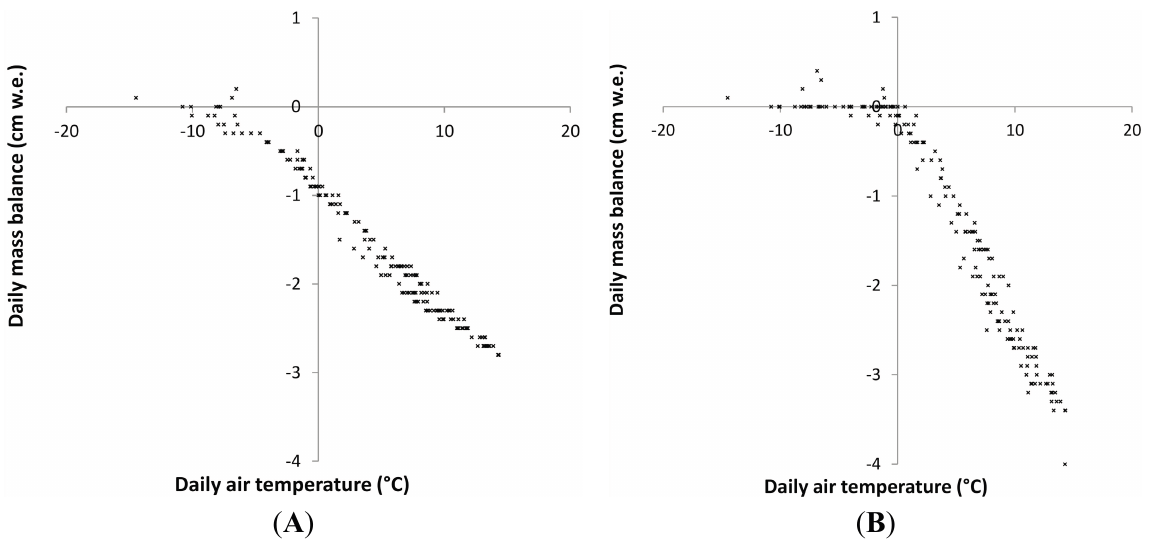
Figure 8. Daily air temperatures and mass balance at 3200 m a.s.l. calculated by ( A ) the energy-balance model and ( B ) the distributed temperature-index model.